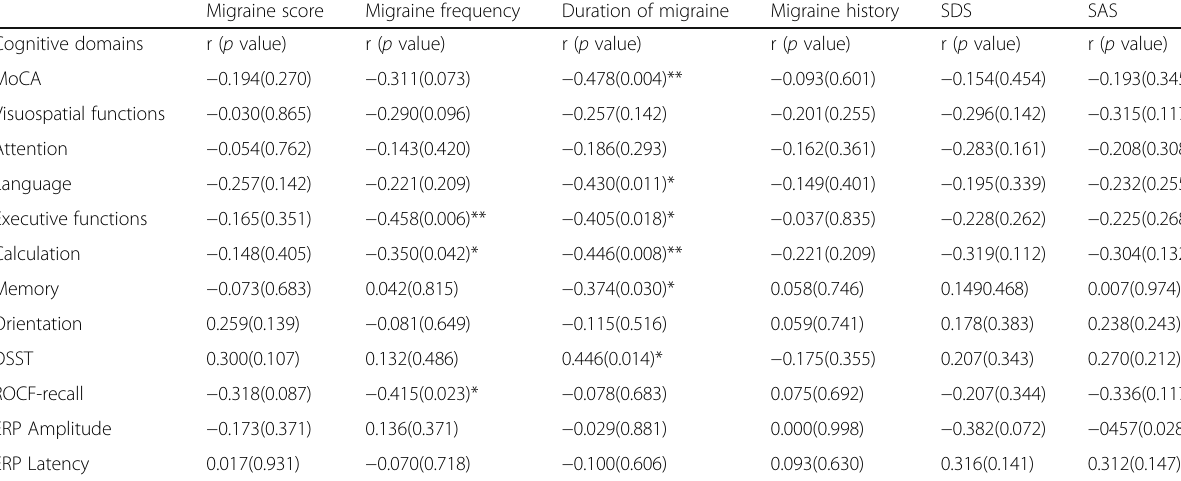
Table 4 Correlation between cognitive scores and headache characteristics in migraine patients Migraine score Migraine frequency Duration of migraine Migraine history SDS SAS Cognitive domains r ( p